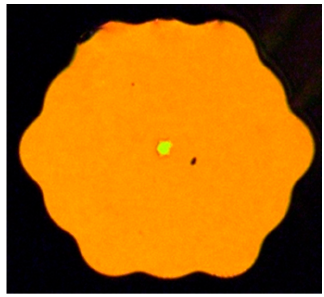
Figure 5. Cross section of tellurite fiber showing core and hexagonal shape (125 µm).